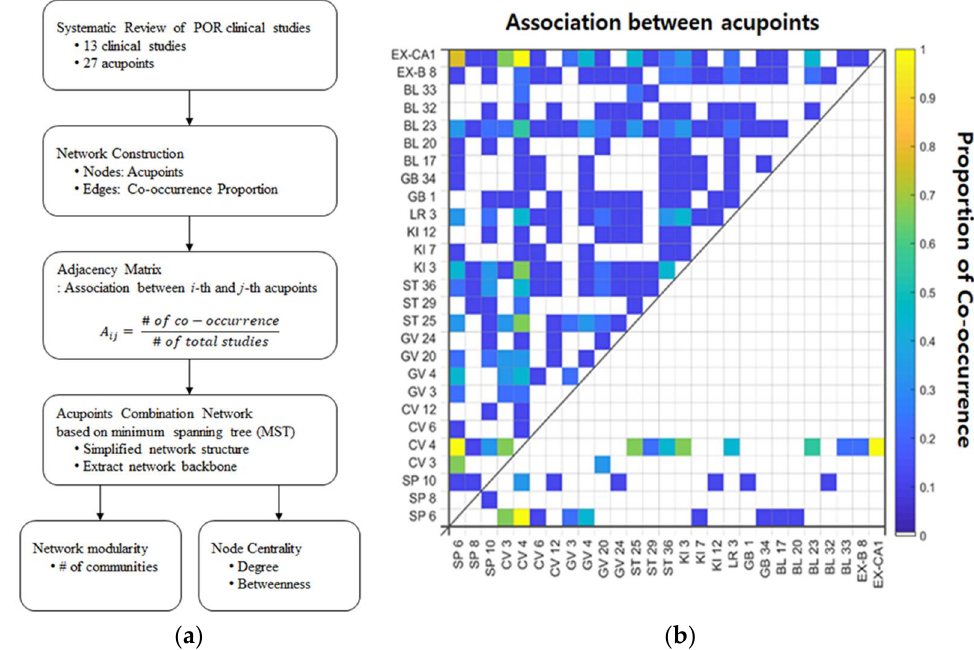
Figure 1. Network construction and adjacency matrix. ( a ) The procedure of network analysis involving the proportion of co-occurrence between acupoints revealed by previous clinical studies; ( b ) The association between acupoints is computed based on the proportion of co-occurrence between two acupoints, and the value is represented in the upper triangular part of the adjacency matrix. In the lower triangular part of the adjacency matrix, the value indicates the proportion of co-occurrence between two acupoints that survived as a result of the application of the minimum spanning tree algorithm. POR, poor ovarian response.